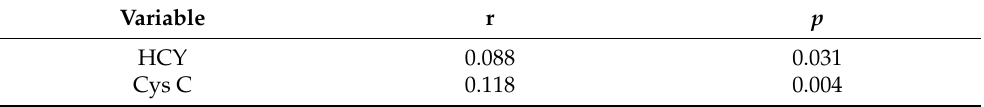
Table 6. Pearson correlation of UA PI and HCY with Cys C.